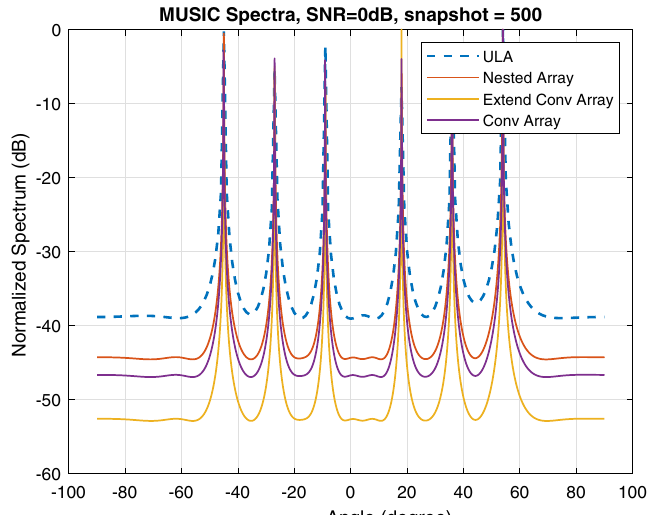
Fig. 3 2D extended sparse conv array of (2,